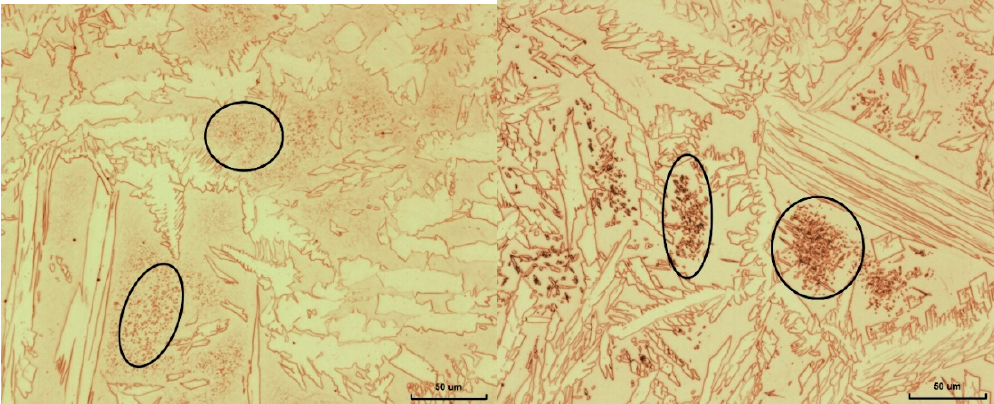
Figure 11. Preferential locations for precipitation of nitrides in the HAZ: primary ferrite grain boundaries, δ / ɣ boundaries and in the ferrite grains.